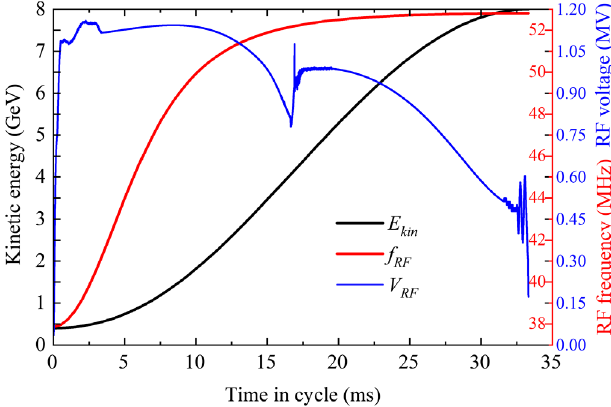
FIG. 2. Booster ramp: kinetic energy (black), rf voltage (blue) and frequency (red).